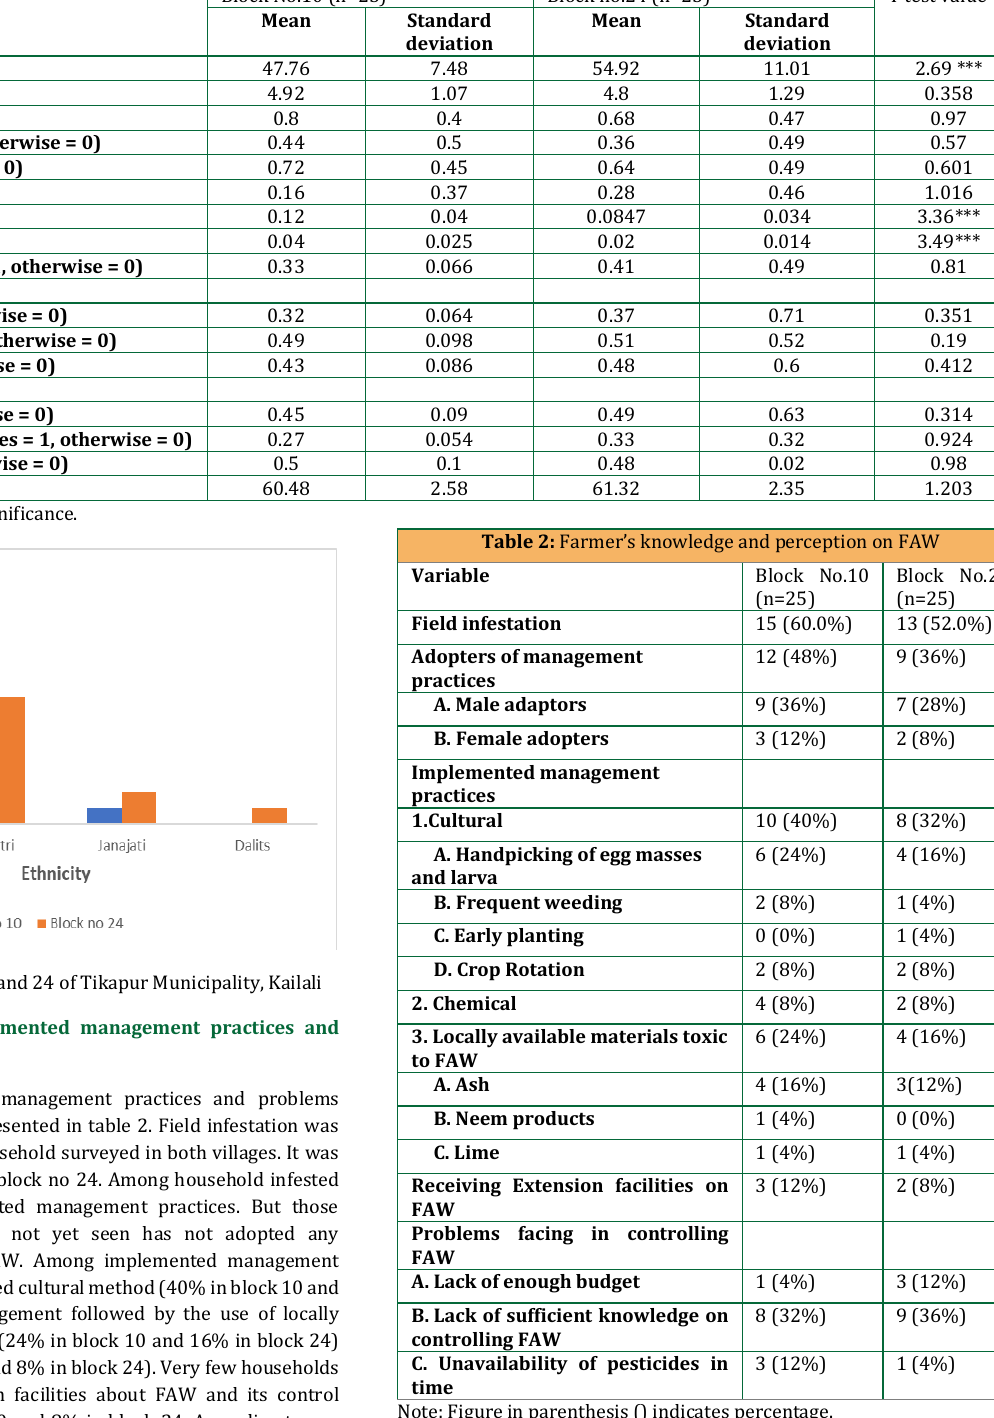
Note: Figure in parenthesis () indicates